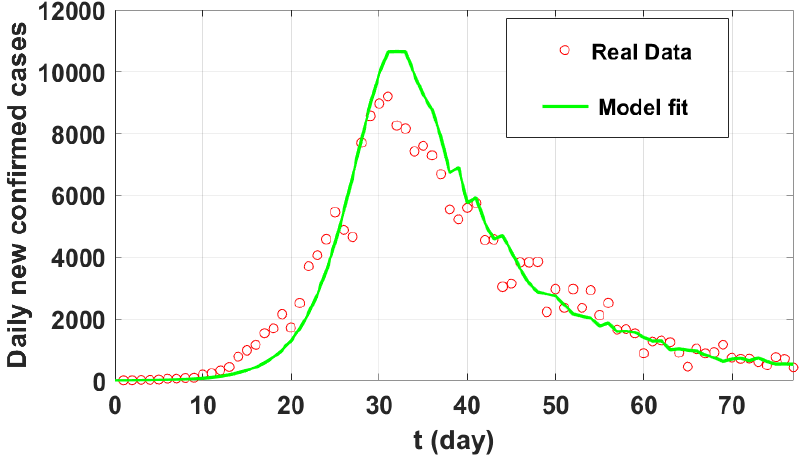
Figure 2. Numerical simulation for system (14–16) at H ∗ = 0.6, α = 0.9, α 1 = 0.87, σ 1 = σ 2 = σ 3 = 0.01, σ 4 = σ 5 = σ 6 = σ 7 = σ 8 = 0.1.